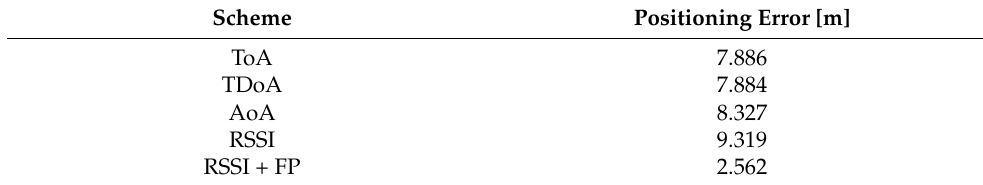
Table 3. Comparison of positioning